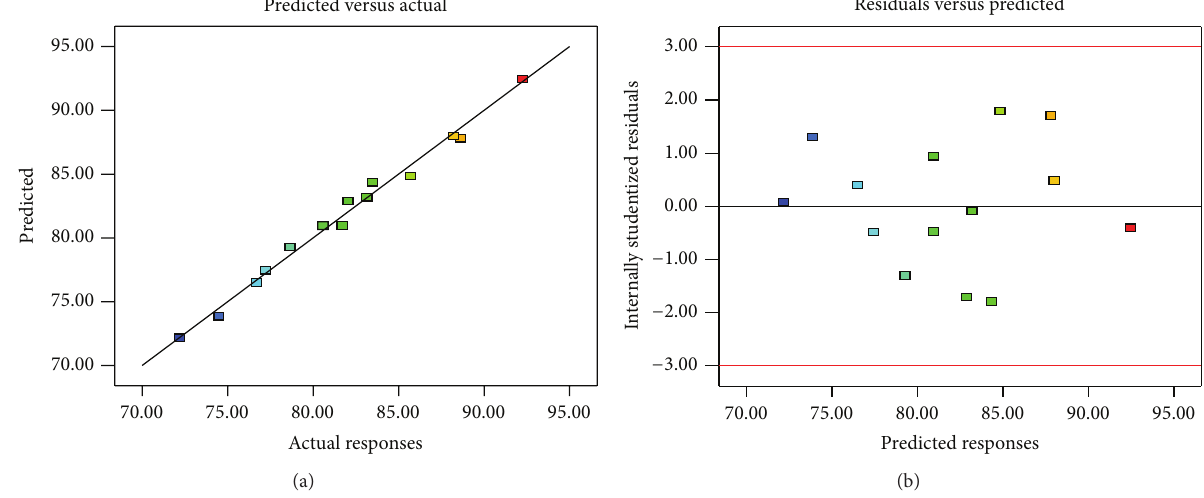
Figure 2: Observed versus predicted responses (a) and internally studentized residuals versus predicted responses